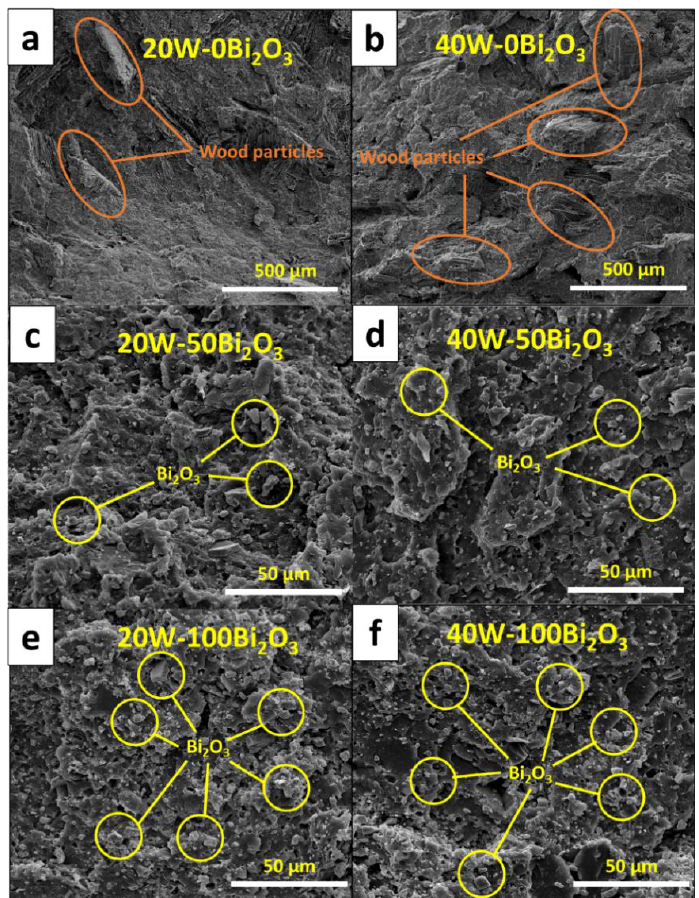
Figure 4. SEM images of WPVC composites containing ( a ) 20 pph wood particles, ( b ) 40 pph wood particles, ( c ) 50 pph Bi 2 O 3 and 20 pph wood particles, ( d ) 50 pph Bi 2 O 3 and 40 pph wood particles, ( e ) 100 pph Bi 2 O 3 and 20 pph wood particles, and ( f ) 100 pph Bi 2 O 3 and 40 pph wood particles.